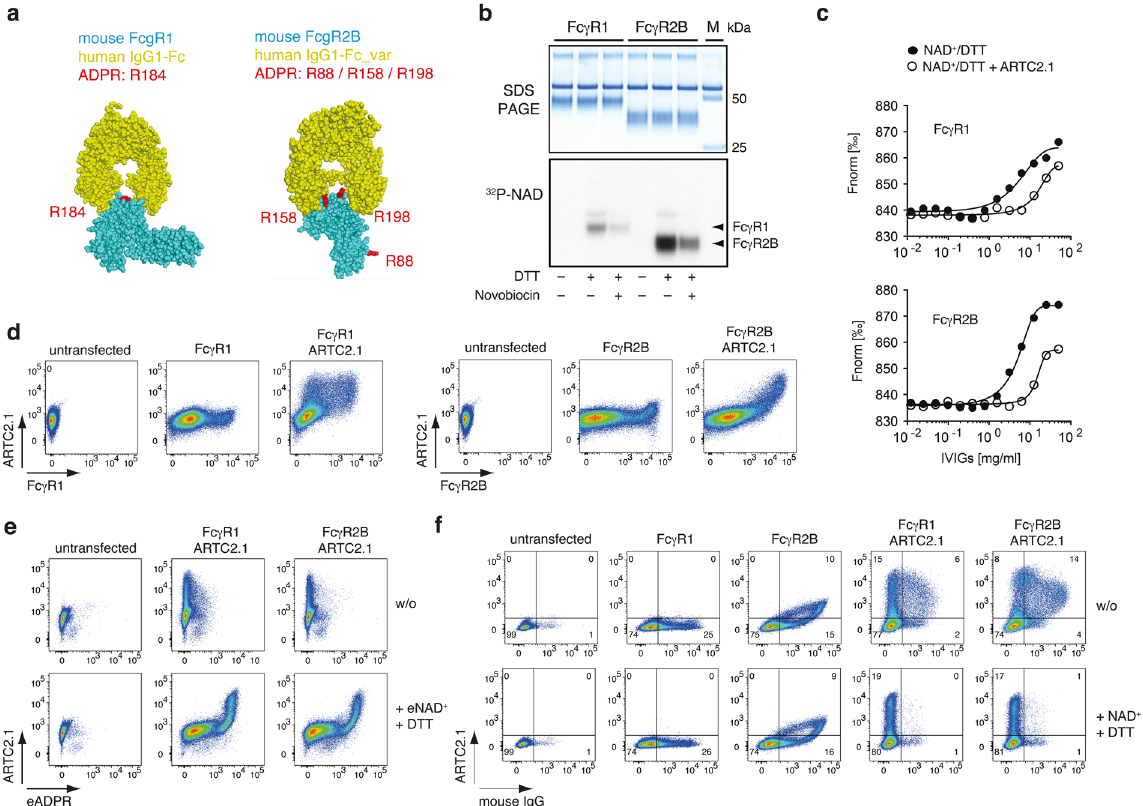
Figure 5. ADP-ribosylation of Fc γ Rs affects binding of IgG to transfected HEK cells. ( a ) Using SWISS- MODEL, the structures of mouse Fc γ R1 and Fc γ R2B 3D structures were modeled on the corresponding structures of human Fc γ R1 (pdb: 4w4o) and Fc γ R2B (pdb: 3wjj) in complex with human IgG1-Fc. Fc γ Rs are displayed in cyan, the Fc portion of IgG1 is shown in yellow. ARTC2.1 target arginines are labeled in red. ( b ) Soluble Fc γ R1 and Fc γ R2B were radiolabeled with 32 P-NAD + (1 µ M) by soluble ARTC2.1 in the presence or absence of DTT (2.5 mM) and the ARTC inhibitor novobiocin. Proteins were fractioned by SDS-PAGE and subjected to autoradiography (cropped). ( c ) Binding of human intravenous immunoglobulins (IVIGs) to ADP- ribosylated or unmodified Fc γ R1 and Fc γ R2B was measured in a thermophoresis assay starting with an IVIG concentration of 50 mg/ml and 1:2 dilution steps. Each dot represents the mean of 4 measurements. ( d ) HEK cells were transfected with Fc γ R1 or Fc γ R2B alone or in combination with ARTC2.1. (e) Ecto-ART activity in Fc γ Rs/ARTC2.1 co-transfected HEK cells was measured after incubation with or without eNAD + /DTT. (f) HEK cells transfected with Fc γ R1/Fc γ R2B or co-transfected with ARTC2.1 were pre-incubated with or without 100 µ M NAD + and 2 mM DTT. Cells were washed and incubated with BALB/c mouse serum (1:20 diluted) and cell surface binding of mouse IgG was measured using a PE-conjugated anti-mouse IgG F(ab) 2 . Data are representative of 2–3 independent